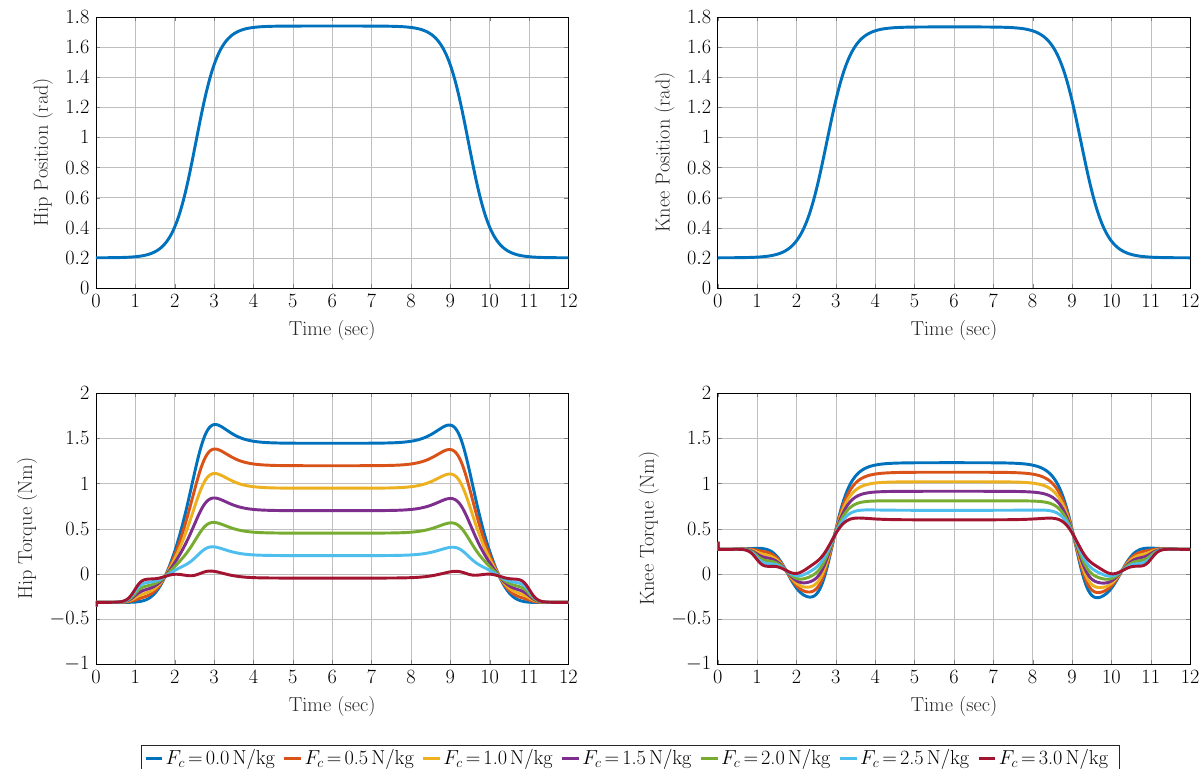
Figure 9. Simulation results of joint torques for knee and hip in dependence on the additional crutch force F c . The forces and torques are normalized to the subject’s